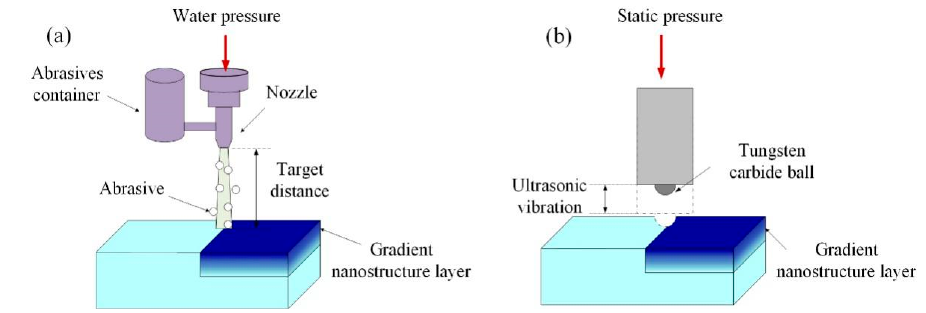
Figure 1. Schematic diagrams of the ( a ) AWJP and ( b ) UNSM processes.